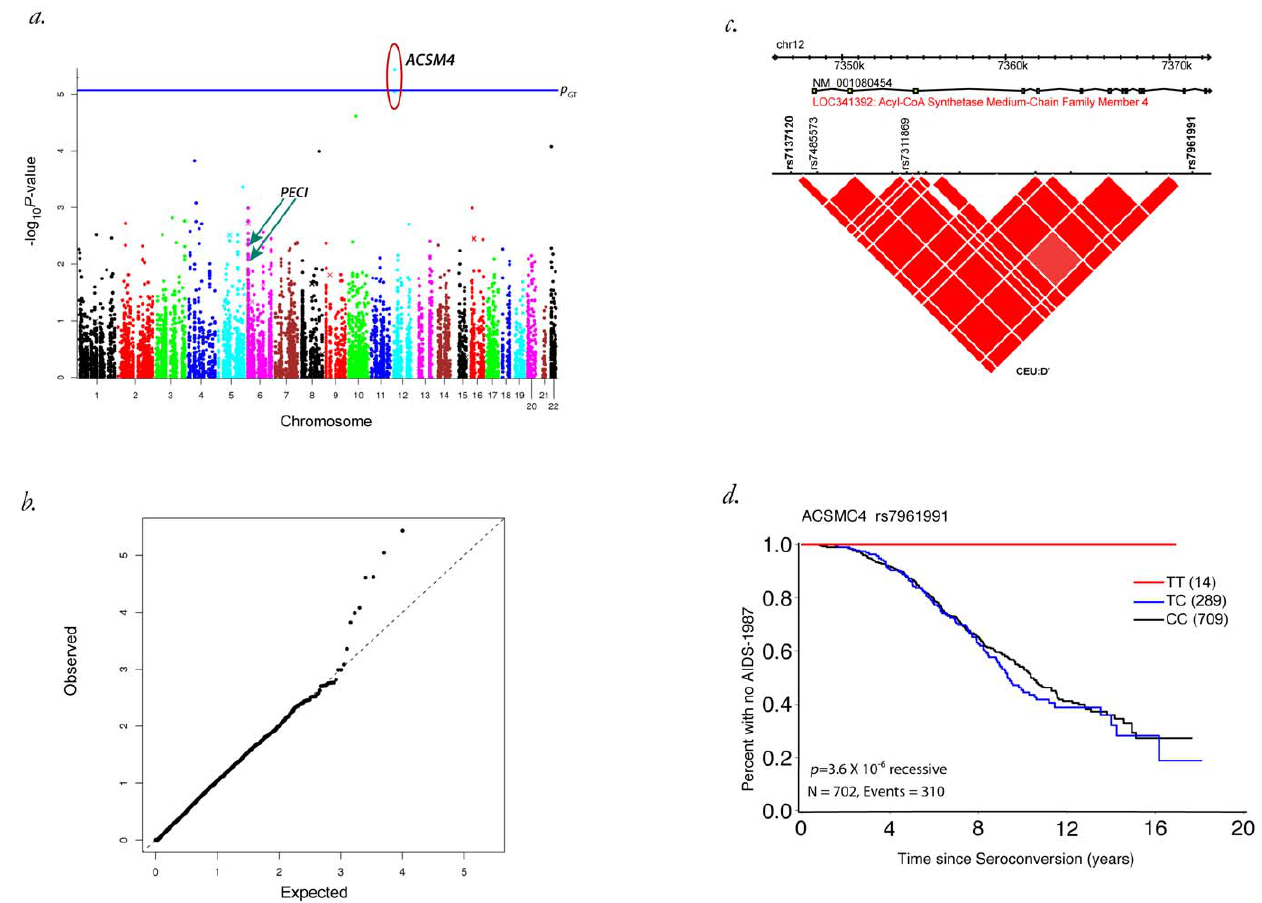
Figure 2. Association of SNPs within the ACSM4 gene region of chromosome 12 with AIDS 1987. Shown as a a) Manhattan plot for time to AIDS-1987 (genetic model-recessive, GT significance threshold is shown as a horizontal line at 9.2 6 10 2 6 ), b) QQ plot, c) gene view of ACSM4 showing SNPs tested and corresponding linkage disequilibrium as inferred by D’ between SNPs, and d) Kaplan-Meier plot of time to AIDS-1987 showing the three ACSM4 genotypes and the p-value for the recessive model. doi:10.1371/journal.pone.0012862.g002 Table 1. SNPs within the NEMP genes that included significant association with time to AIDS-1987 CDC definition [30].